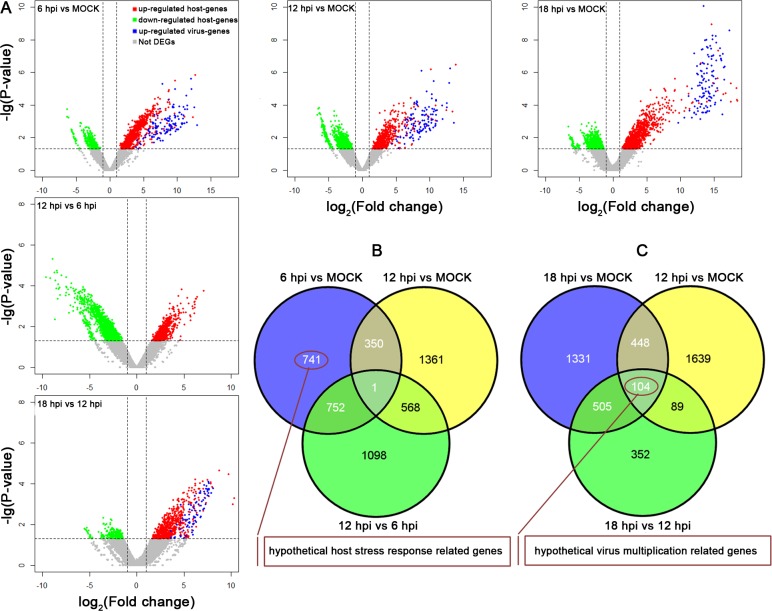
Volcano plots of up/downregulated and non-differentially expressed SL221 unigenes and viral genes throughout infection.A: Unigene expression levels between cells at 6/12/18 hpi and mock (horizontal axis), and unigene expression levels between adjacent infection time points (vertical axis). DEG: differentially expressed genes. B: Venn diagrams showing the protein overlap in biological replicates of cells at mock, 6 hpi and 12 hpi. C: Venn diagrams showing the protein overlap in biological replicates of cells at mock, 12 hpi and 18 hpi.